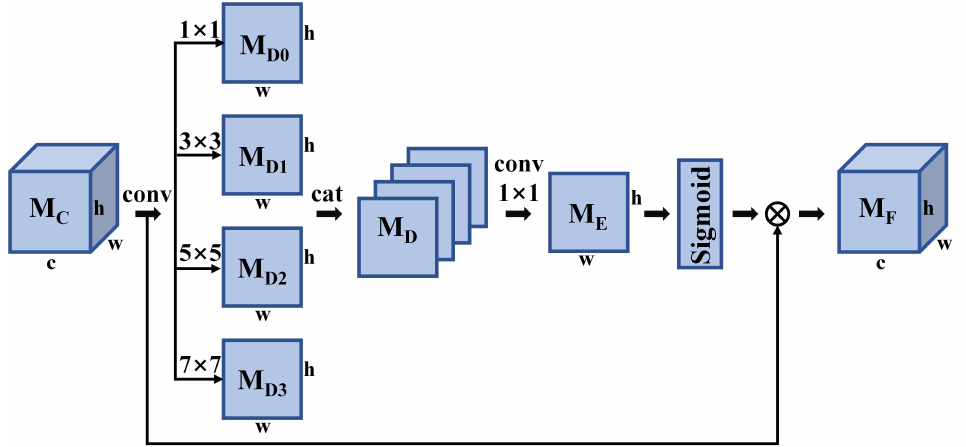
Figure 4. The structure of the MSAM. We apply appropriate padding to ensure the same output